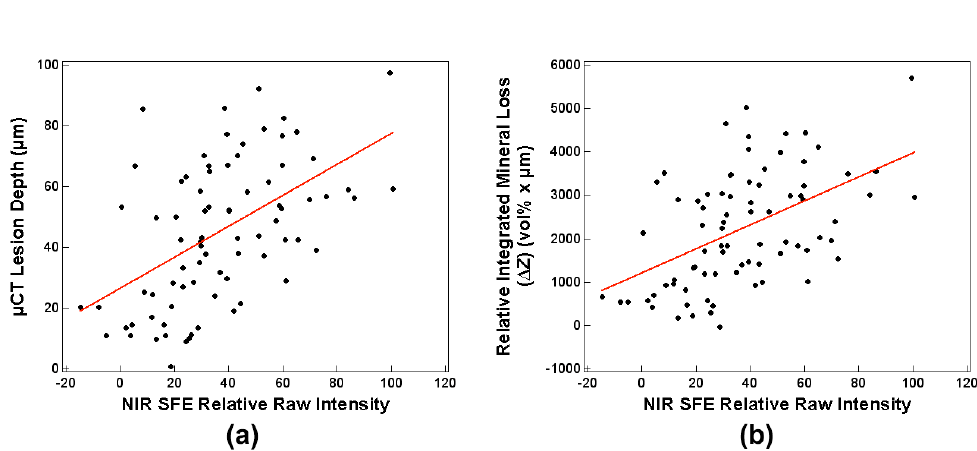
Figure 7. Plots of NIR SFE relative raw intensity measurements in the dry condition using 1460-nm light vs. ( a ) lesion depth and ( b ) relative integrated mineral loss (n = 80). light vs. ( a ) lesion depth and ( b ) relative integrated mineral loss (n =